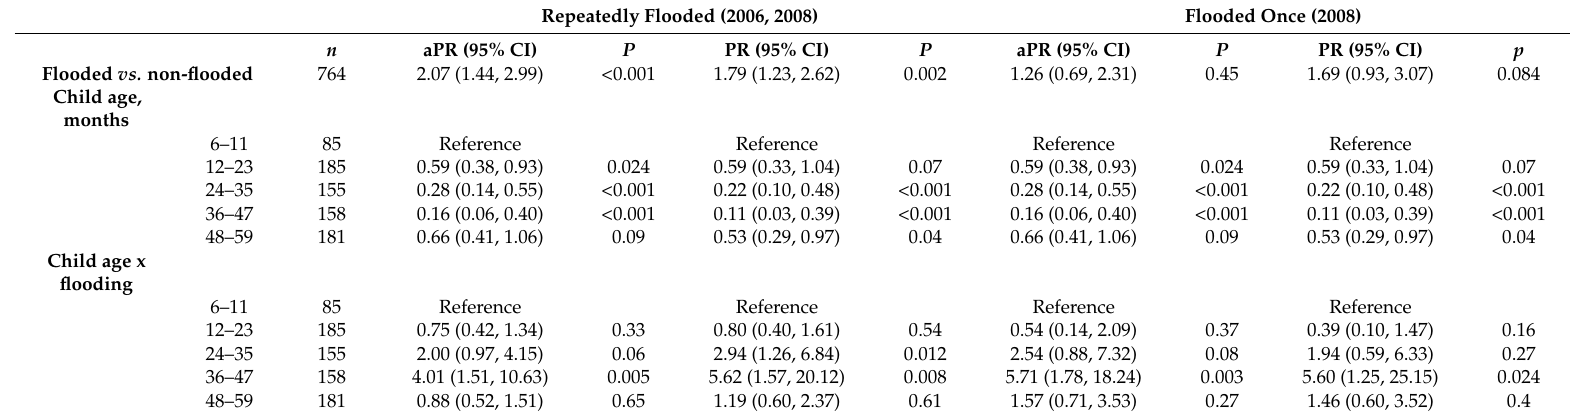
Table 3. Interaction of the prevalence of total wasting by age groups with number of floods experienced (0,1,2) for adjusted and crude models in 6 to 59 months children in rural Jagatsinghpur district, Odisha,